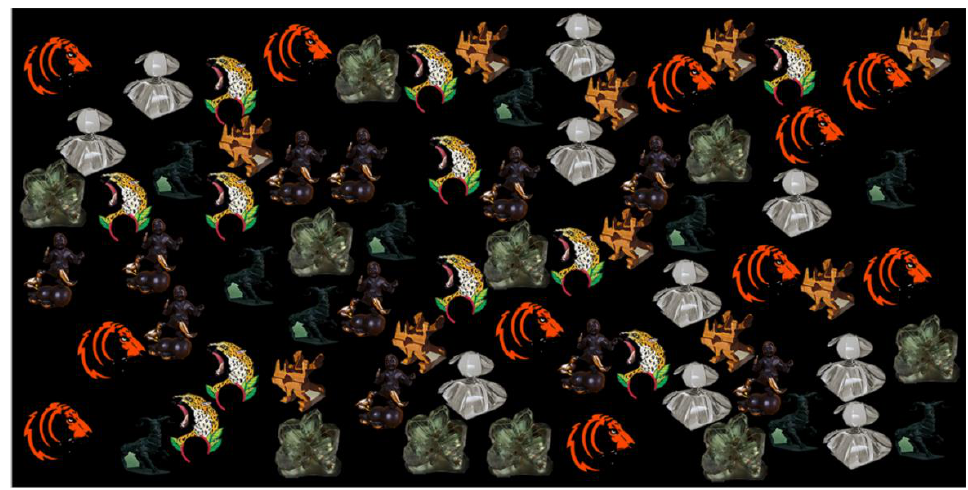
Figure 19. Solution found by the ILS algorithm when inserting 73 pieces for the A2 instance, consuming 4 h of processing time.